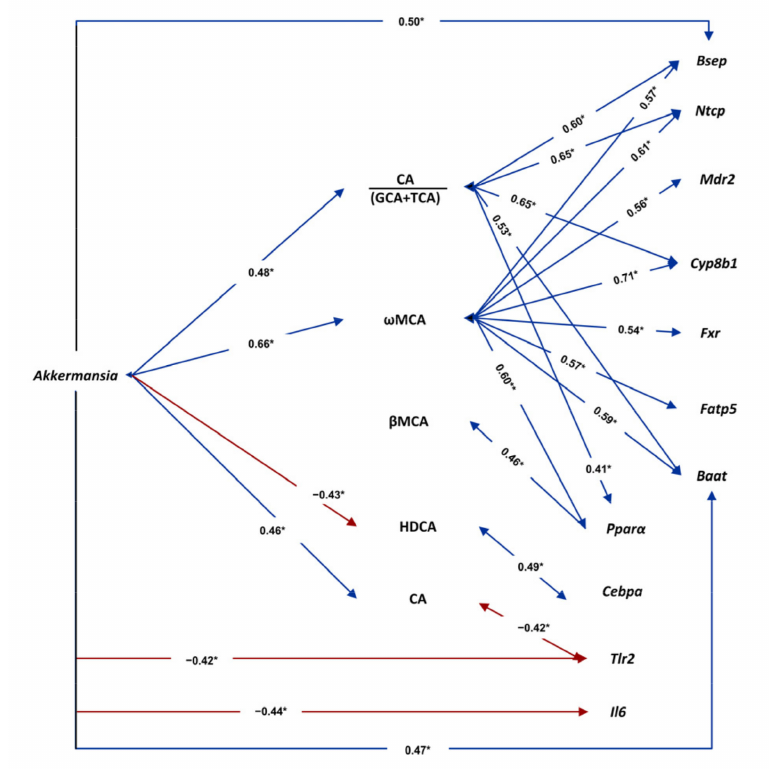
Figure 8. Associations of gut Akkermansia genus with plasma BAs and with hepatic gene expression. The values in bidirectional arrows represent the Pearson’s correlation coefficients; * p < 0.05. Detailed XY representation of each association is provided in the Figure